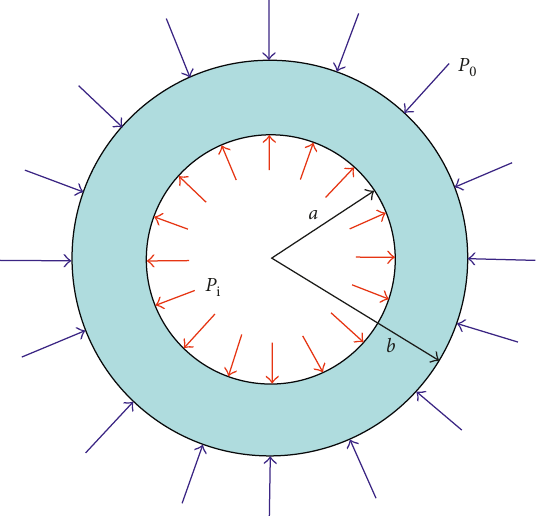
Figure 1: Distribution of stresses around a hollow cylinder.